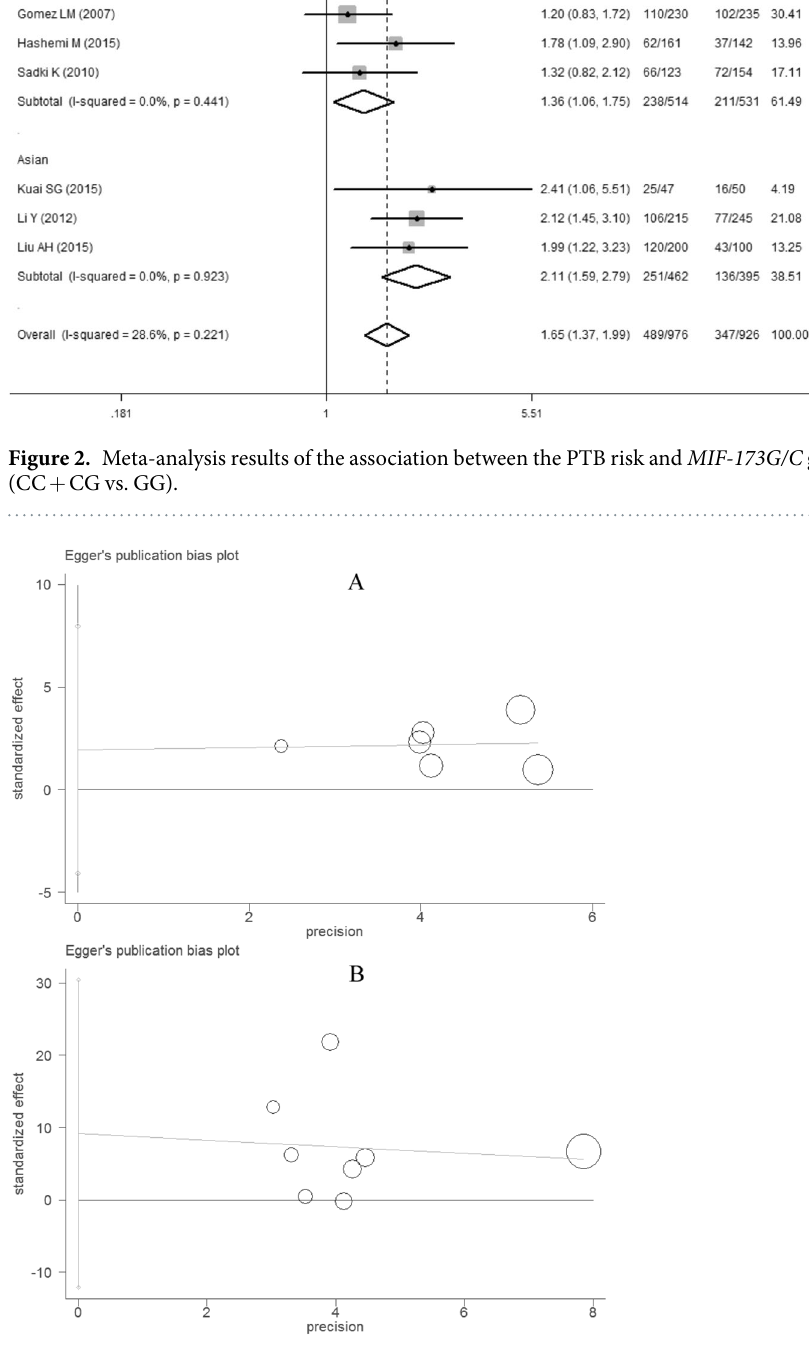
Figure 3. Funnel plot for evaluating publication bias on the association between the PTB risk and MIF-173G/C gene polymorphism ( A ) as well as on the association between the serum MIF levels and PTB ( B ). Each circle represents a separate study for the indicated